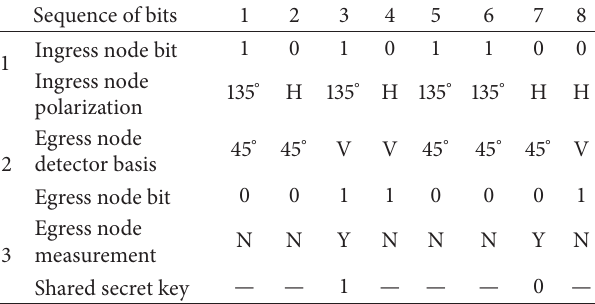
Table 2: An 8-bit sample for B92 protocol.